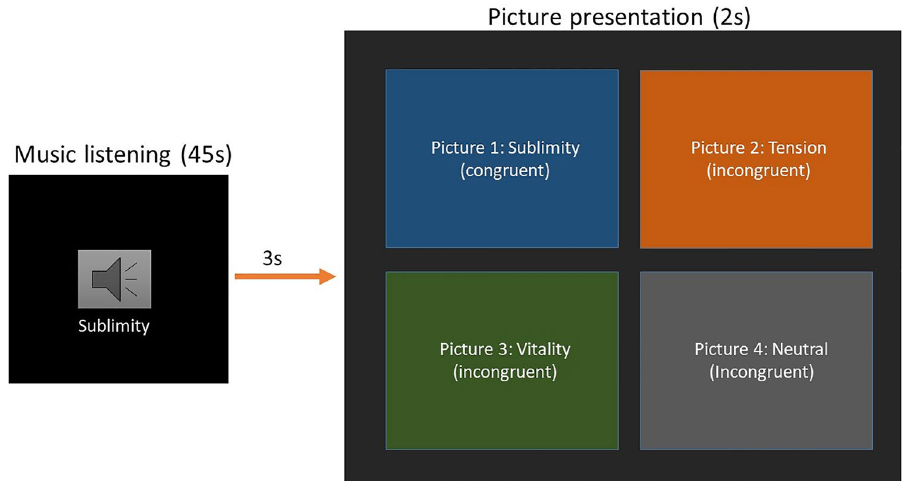
Figure 1. Example of a trial where the participant listens to a musical excerpt belonging to the “sublimity” emotional category, and then looks at the pictures appearing on the screen. Examples of the original pictures cannot be shown because of redistribution limitations imposed by the EmoMadrid